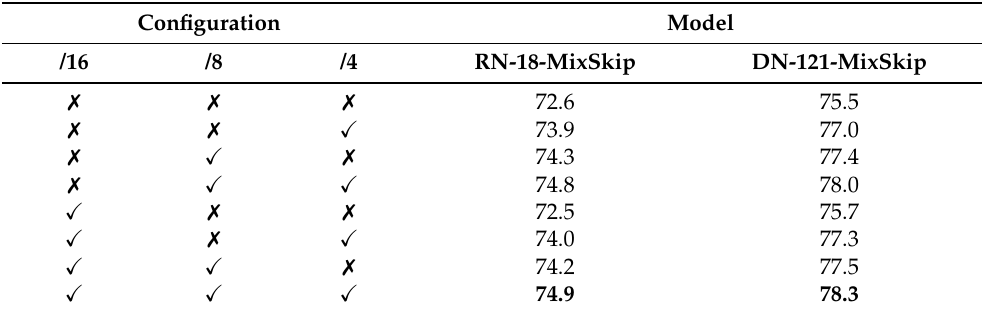
Table 2. Validation of per-skip contributions on semantic segmentation accuracy (mIoU) on Cityscapes val.